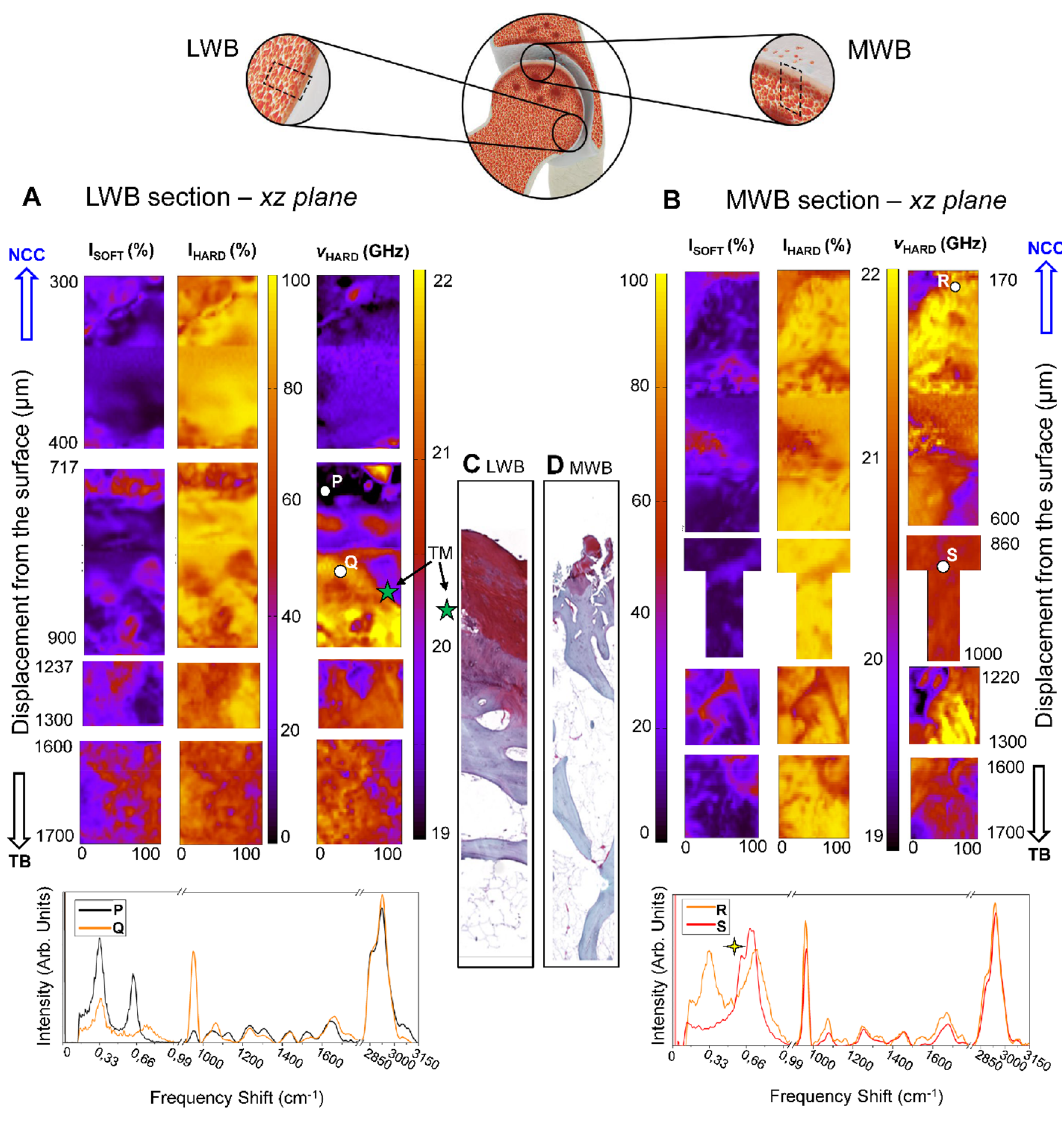
Figure 3. Mechanical imaging of the least weight-bearing (LWB) and most weight-bearing (MWB) sections in the xz plane of the non-calcified cartilage (NCC) and the subchondral and trabecular bone (TB) of biopsy#2, revealing the main differences in their elastic properties. ( A ) At the top, Brillouin maps reporting the distribution of the relative percentage of P SOFT and P HARD components, namely I SOFT and I HARD , with the frequency shift of the hard component ν HARD , collected in the LWB section of biopsy#2. At the bottom are Brillouin and Raman spectra of points of interest in the map (P-black, Q-orange). ( B ), At the top, Brillouin maps reporting the distribution of the relative percentage of P SOFT and P HARD components, namely I SOFT and I HARD , with the frequency shift of the hard component ν HARD , collected in the MWB section of biopsy #2. At the bottom are Brillouin and Raman single-point spectra of points of interest in the maps (R-orange, S-red). The yellow star stresses the presence of a double-peaked signal in the BLS spectrum. Histological assessment of OA grade in the LWB ( C ) and the MWB sections ( D ) of biopsy#2 through Safranin-O/Fast Green staining. Green stars point out the TM-tidemark spectrum S (red) with respect to spectrum R (orange), potentially denoting a decreased ability to resist mechani- cal damage of the bony tissues more affected by the OA progression. Safranin-O/Fast Green staining of LWB and MLB sections shown in Fig. 3C,D and more in detail in Fig. 4 below confirms our findings. Specifically, it evidences a well recognizable transition between the non-calcified articular cartilage and the subchondral bone (SB) marked by the tidemark (TM) as regards the LWB sample (Figs. 3C, 4A,B). Concerning the cartilaginous compartment, some irregularities due to the presence of discon- tinuities, fibrillation zones and mild erosion phenomena can be noted, as well as the presence of a non-ordered extracellular matrix lacking in the cellular component, confirming the suspected onset of cartilage degenera- tion (Mankin score 8.0). Otherwise, an extended and severe cartilage erosion characterizes the MWB sample (Figs. 3D, 4C,D ) getting to involve the mineralized cartilage and, in some zones to the level of subchondral